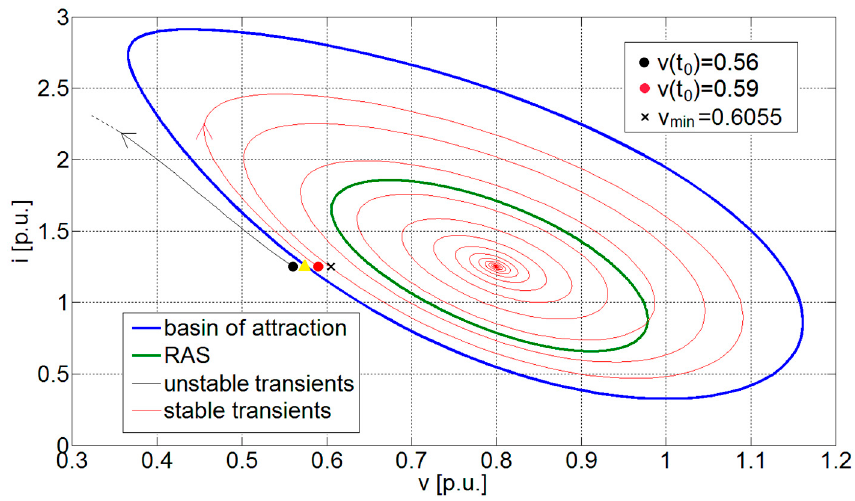
Figure 6. BA and region of asymptotic stability (RAS); validation when v 0 = 0.8 p.u.